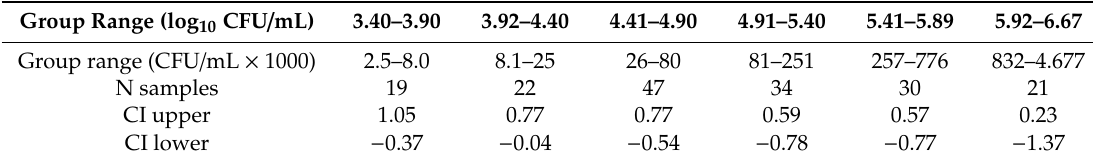
Table 2. Confidence interval (CI) results for the 6 categories identified in the study.